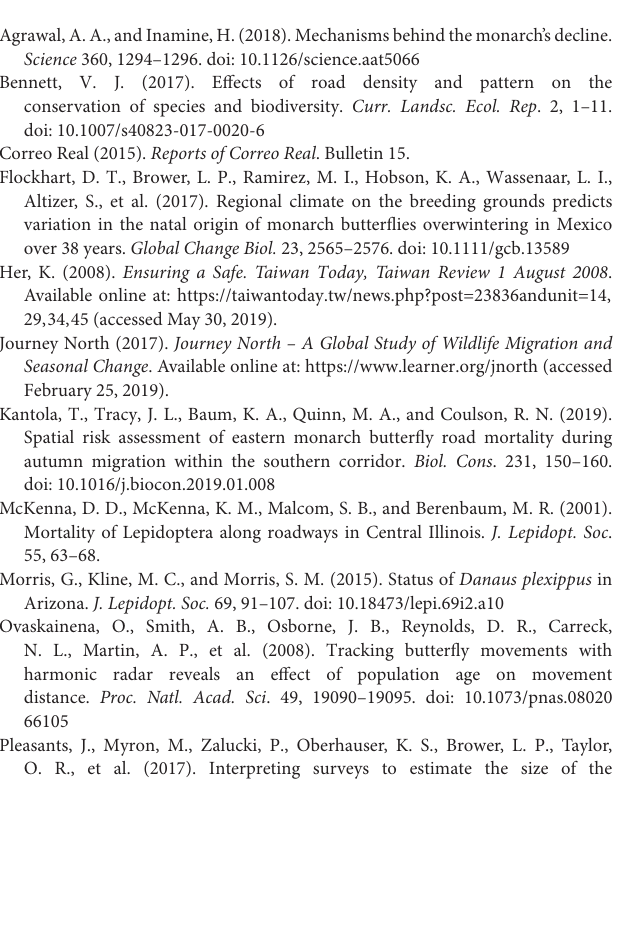
Supplementary Figure S1 | Highway 57 at the La Muralla study site, Coahuila. Photo by B. Xiomara Mora Alvarez. Supplementary Figure S2 | Toll highway 40-D at the Santa Catarina study site in Nuevo León. Photo by Omar Franco Reyes. Supplementary Figure S3 | Bags of dead monarchs collected on one transect day from the Toll Highway 40-D in Santa Catarina, Nuevo León. Photo taken by Rogelio Carrera